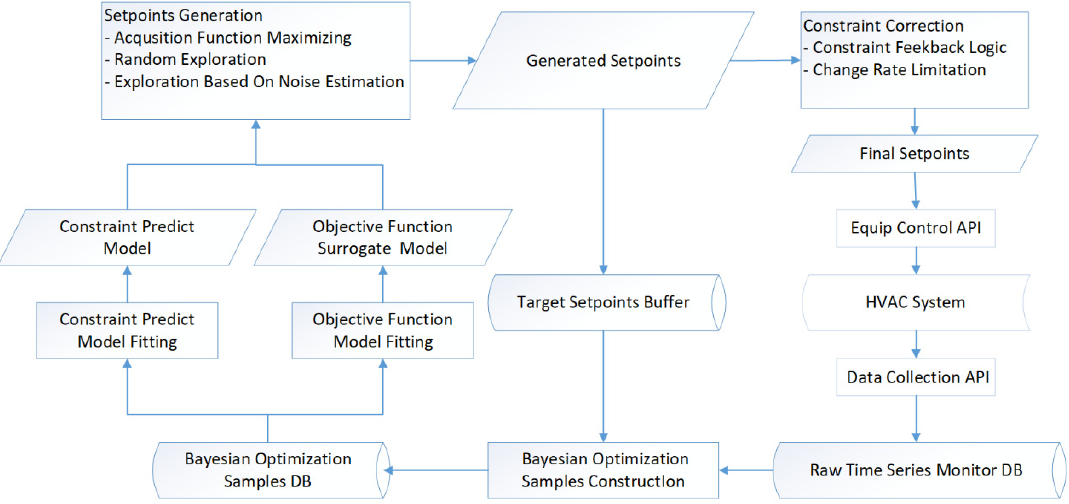
Figure 1. The overall framework of Bayesian optimization for HVAC control.